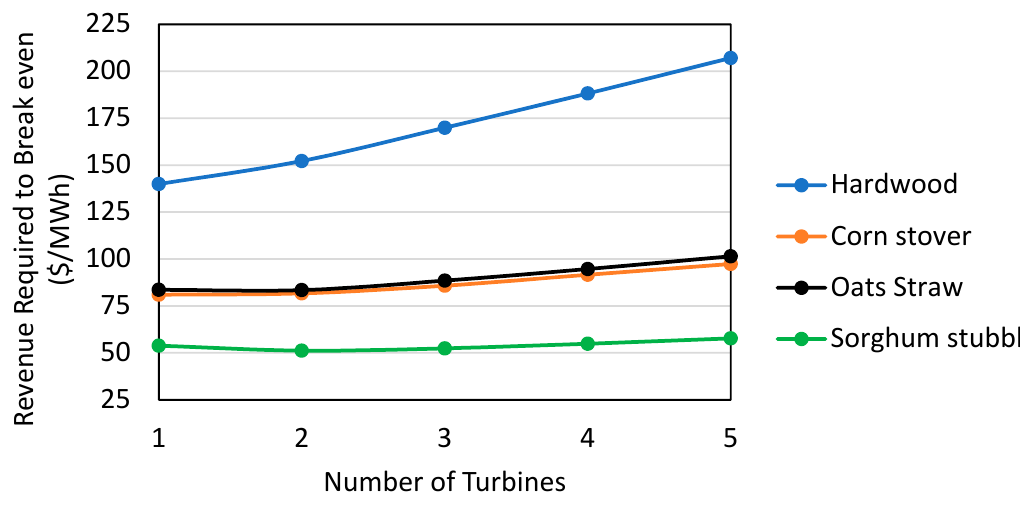
Figure 11. Cost of producing electricity in IGCC powerplants with different types of feedstock.